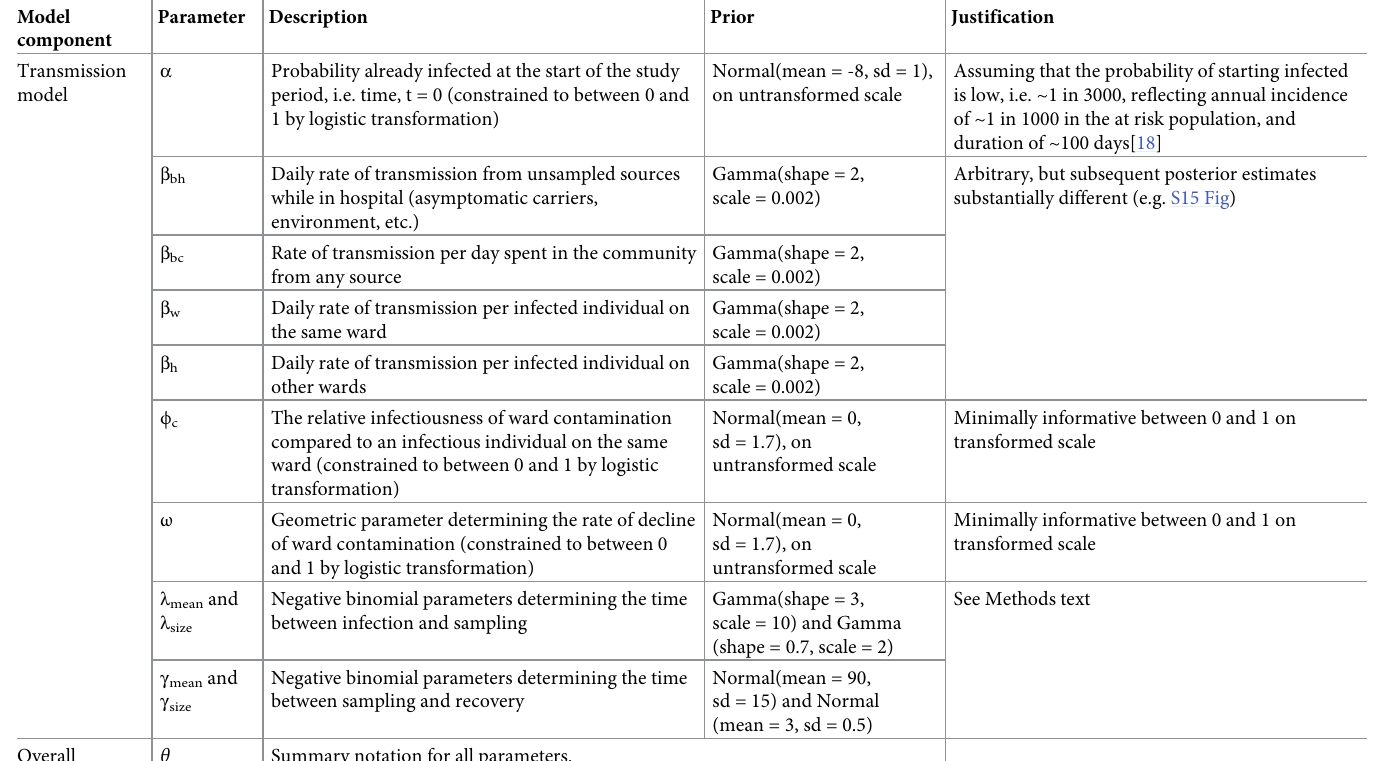
Table 1. Transmission model parameters and priors. For parameters constrained to be positive, normal priors were truncated at zero. In addition to the listed parame- ters, augmented data included the unobserved transmission tree, consisting of infection times and sources denoted T and the set of unobserved recovery times denoted R